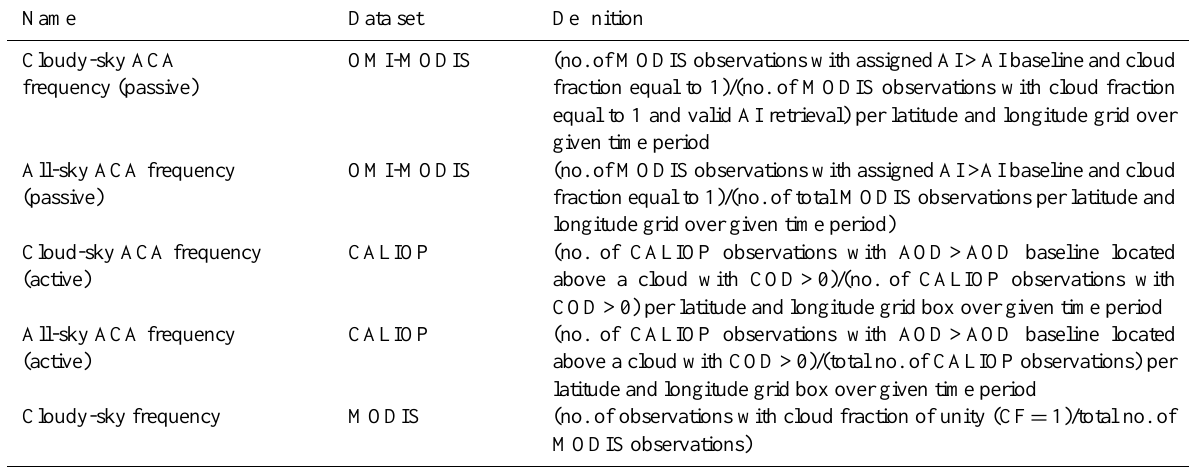
Table 1. Various definitions of frequency of above-cloud aerosols (ACA) used throughout the study.